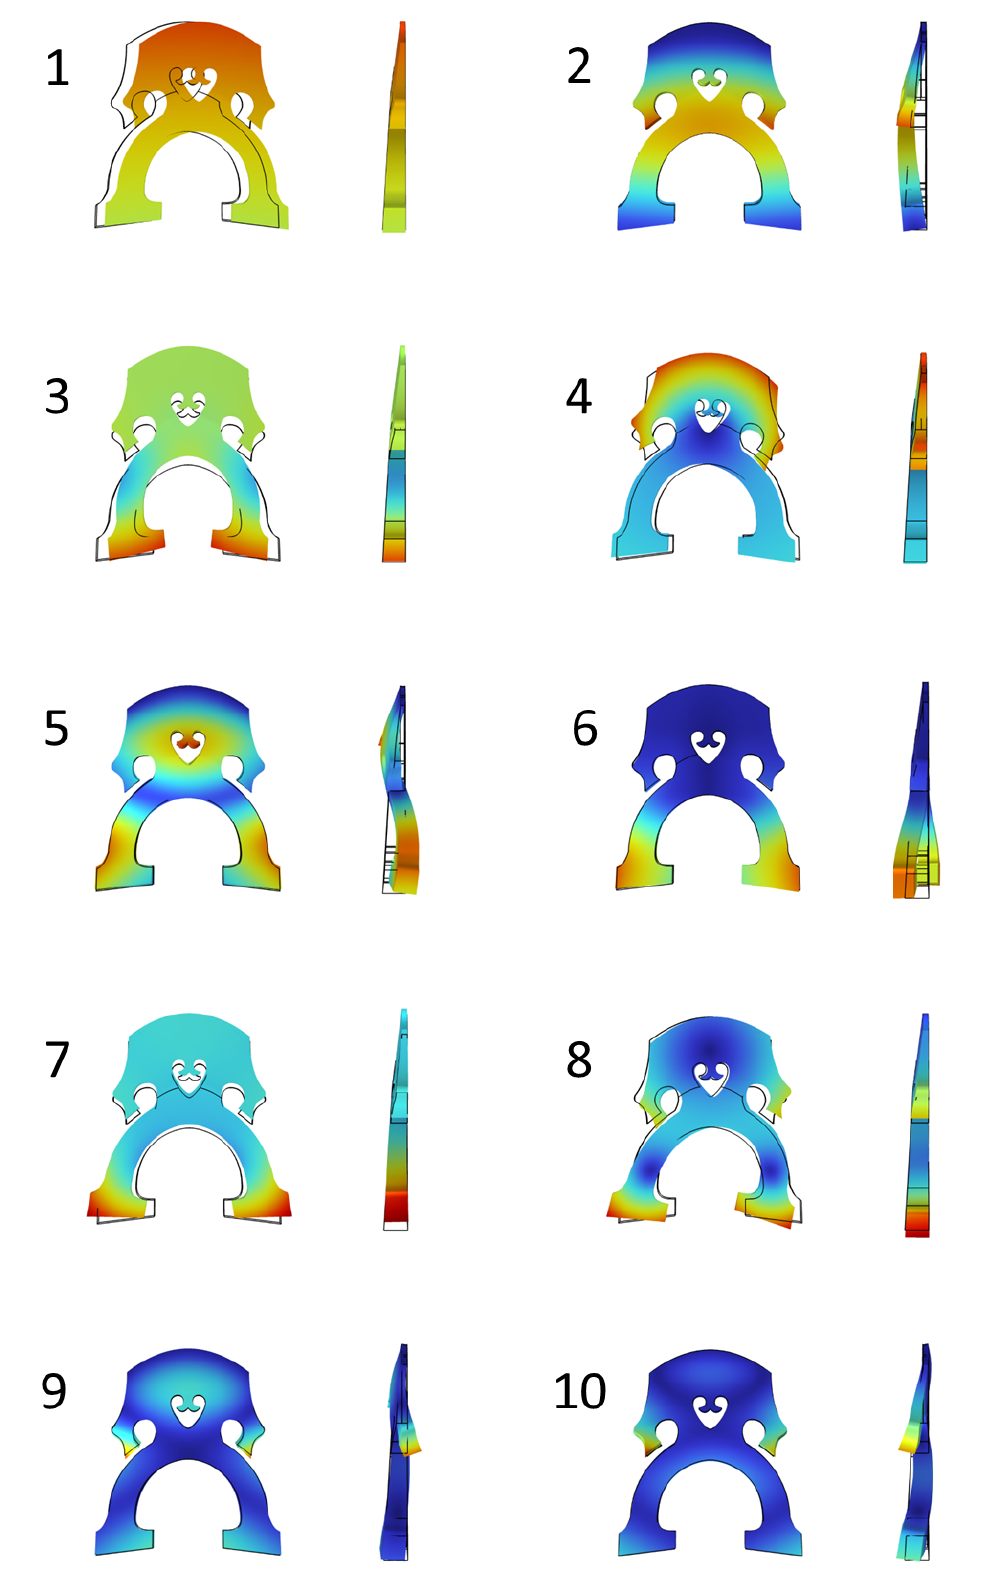
Figure A8. Mode shapes in spring boundary conditions (case (d)) for the Normal